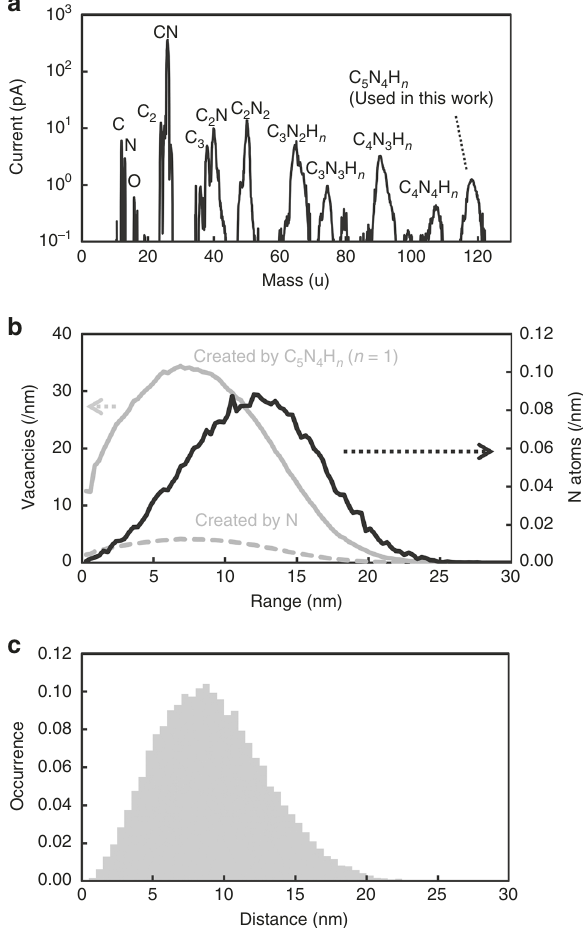
Fig. 4 Features of the C 5 N 4 H n ions from the adenine ion source. a Mass spectrum of ions from the adenine ion source. A C 5 N 4 H n ion was used in this study. The mass of C 5 N 4 H n was evaluated to be 118.2 ± 1.4 u. b Vacancy and nitrogen atom distributions calculated with the SRIM code. The dashed and solid grey lines show the distributions of vacancies created by the nitrogen and C 5 N 4 H n = 1 ions. The solid black line shows the position of the implanted nitrogen atom. c The separation distance distribution between two nitrogen atoms when two nitrogen ions are implanted at the same point. The average distance and standard deviation of the implanted nitrogen atom were calculated to be 9 and 4 nm,